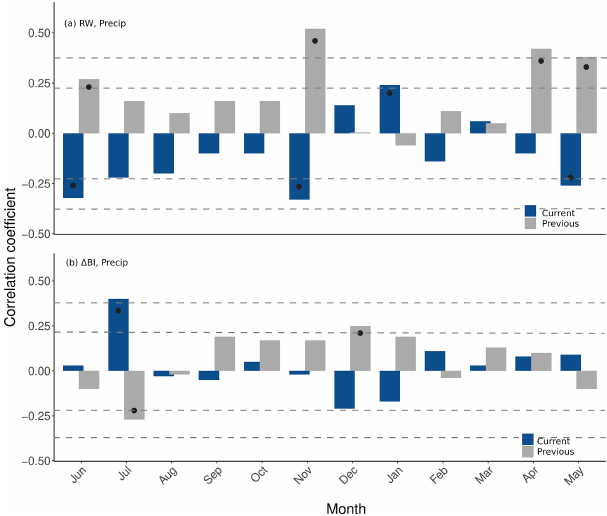
Figure 8. Correlations between (a) RW and (b) (cid:49) BI chronolo- gies and total monthly precipitation data from Harrietville obser- vation station across the period 1929–1998, for both the current and previous growth season. Black dots indicate statistical significance ( p < 0 .